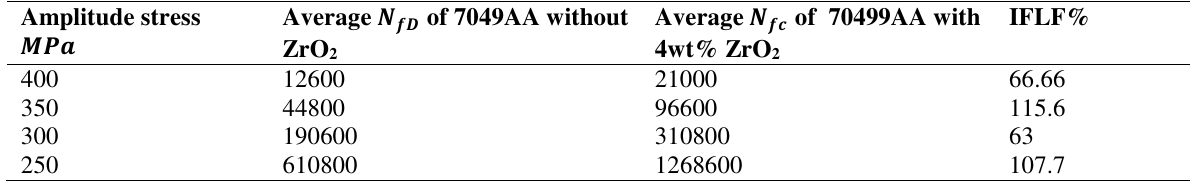
The empirical fatigue power law regression